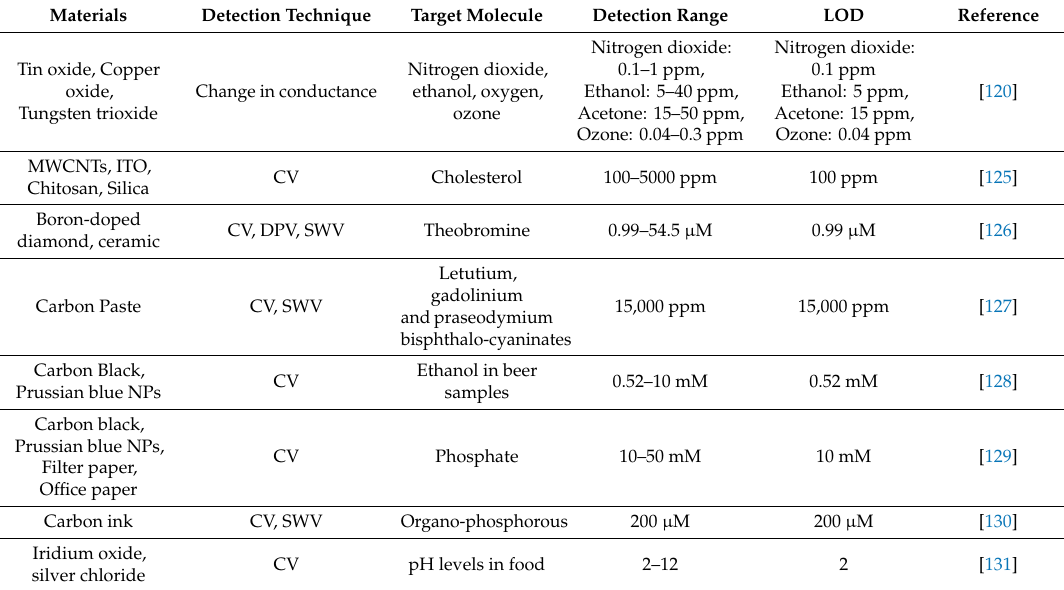
Table 6. Comparison of the nanoparticle-based sensors used for the detection of food quality.